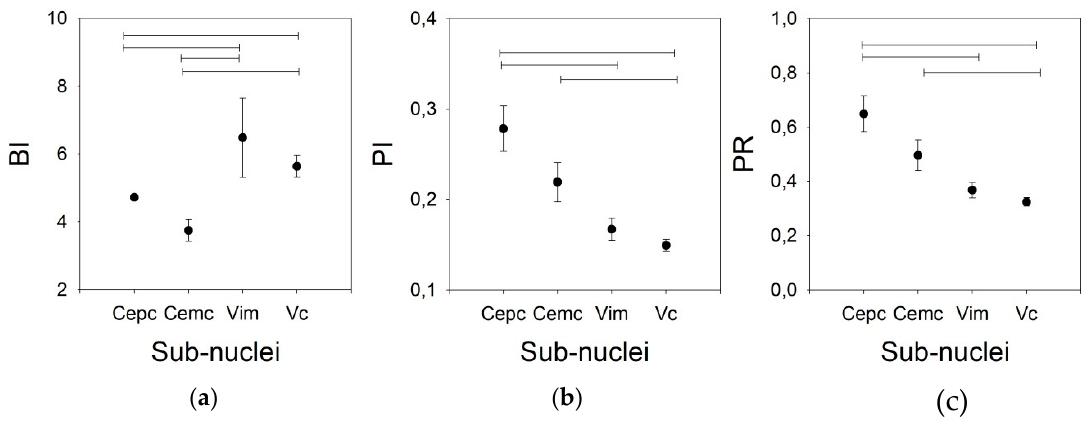
Figure 5. Phasic properties for the four nuclei for the 20/100 ms threshold pair. ( a ) BI, ( b ) PI, ( c ) PR. Horizontal lines indicate statistically significant differences between pairs of nuclei according to the Kruskal–Wallis analysis of variance test.